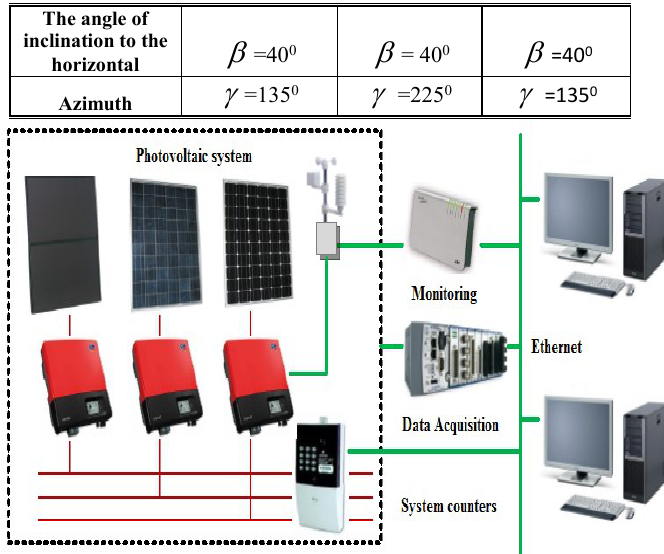
Fig 1. Photovoltaic System at the Faculty of Electrical Engineering Wroclaw University of